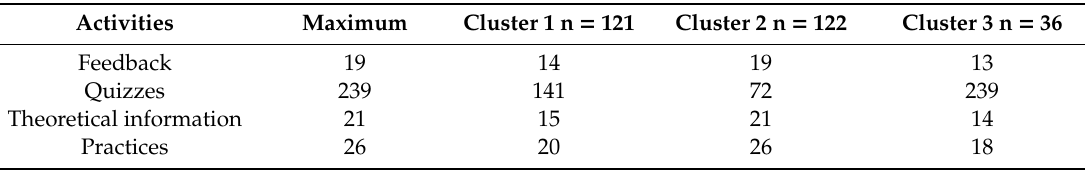
Table 4. Contingency table between students in the two grades and the distribution in the clusters.